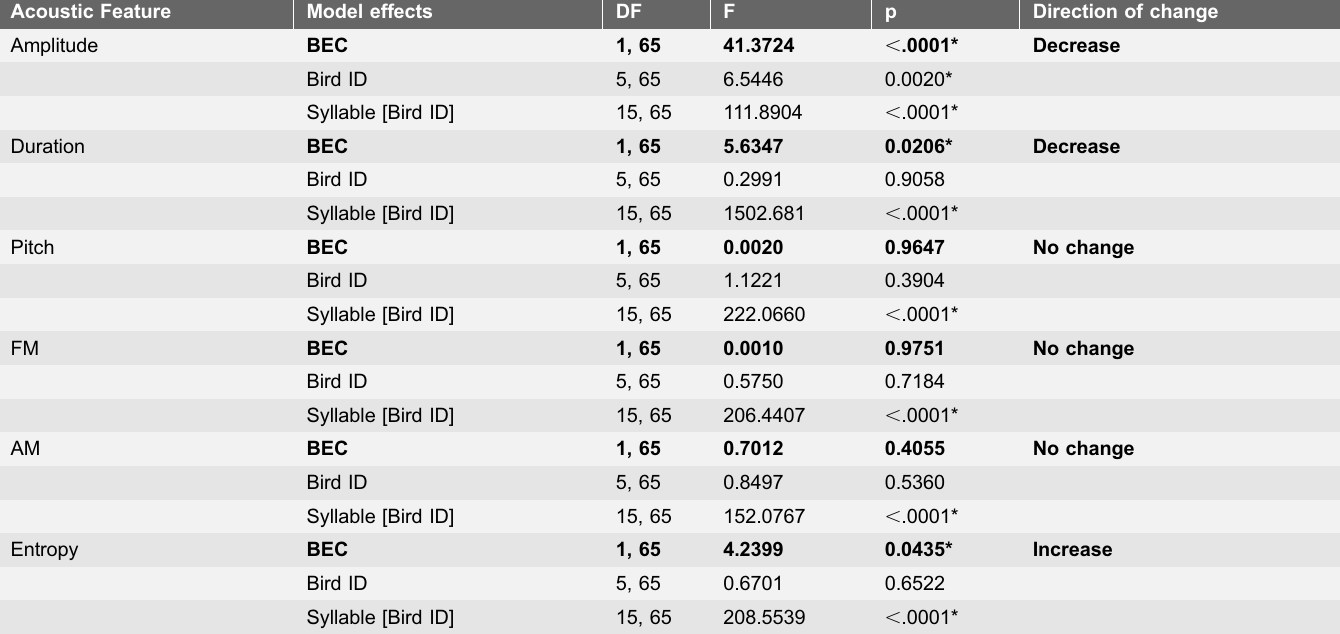
Table 1. ANOVA tables for the effects of BEC (a main effect) and individual Bird ID and syllable nested within bird ID as random effects. Acoustic